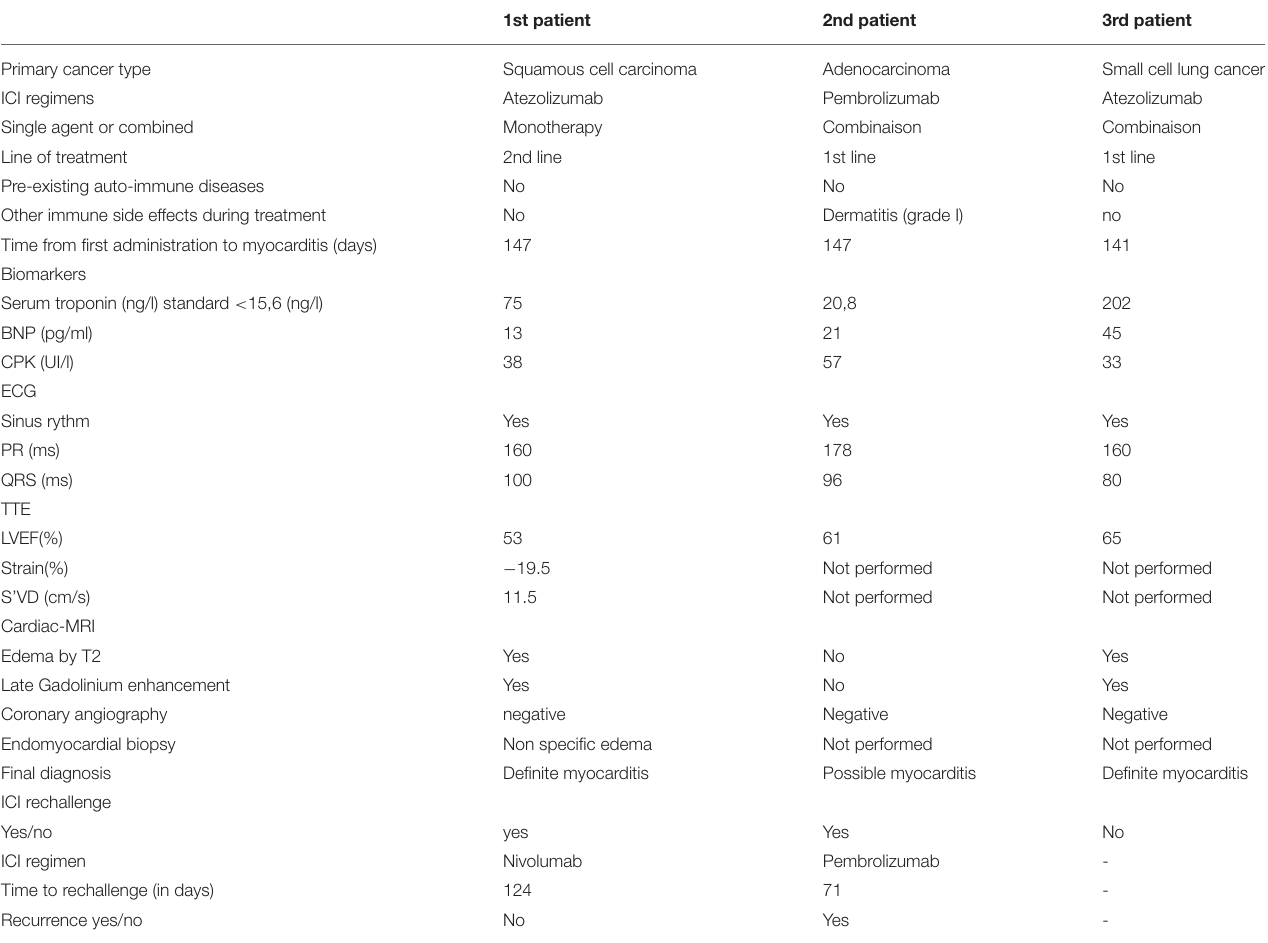
TABLE 3 | Description of myocarditis cases.